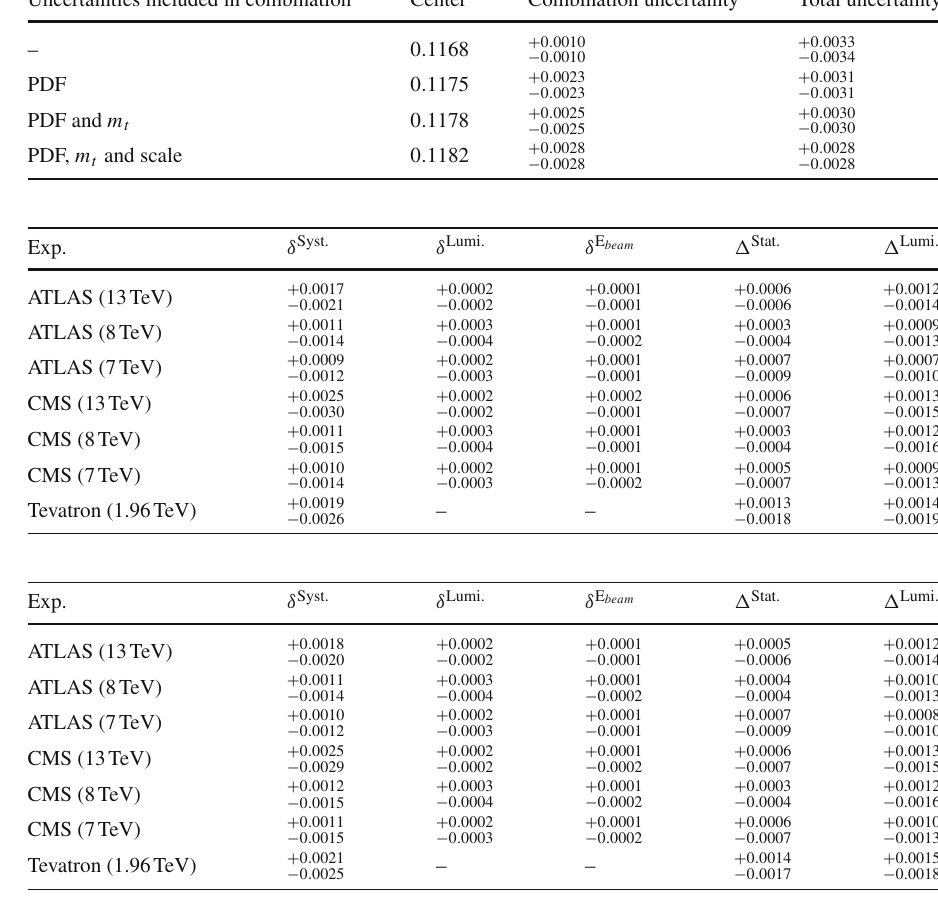
Table 13 As in Table 10, but now using NNLO + NNLL cross sections with the NNPDF30_nolhc series of PDFs